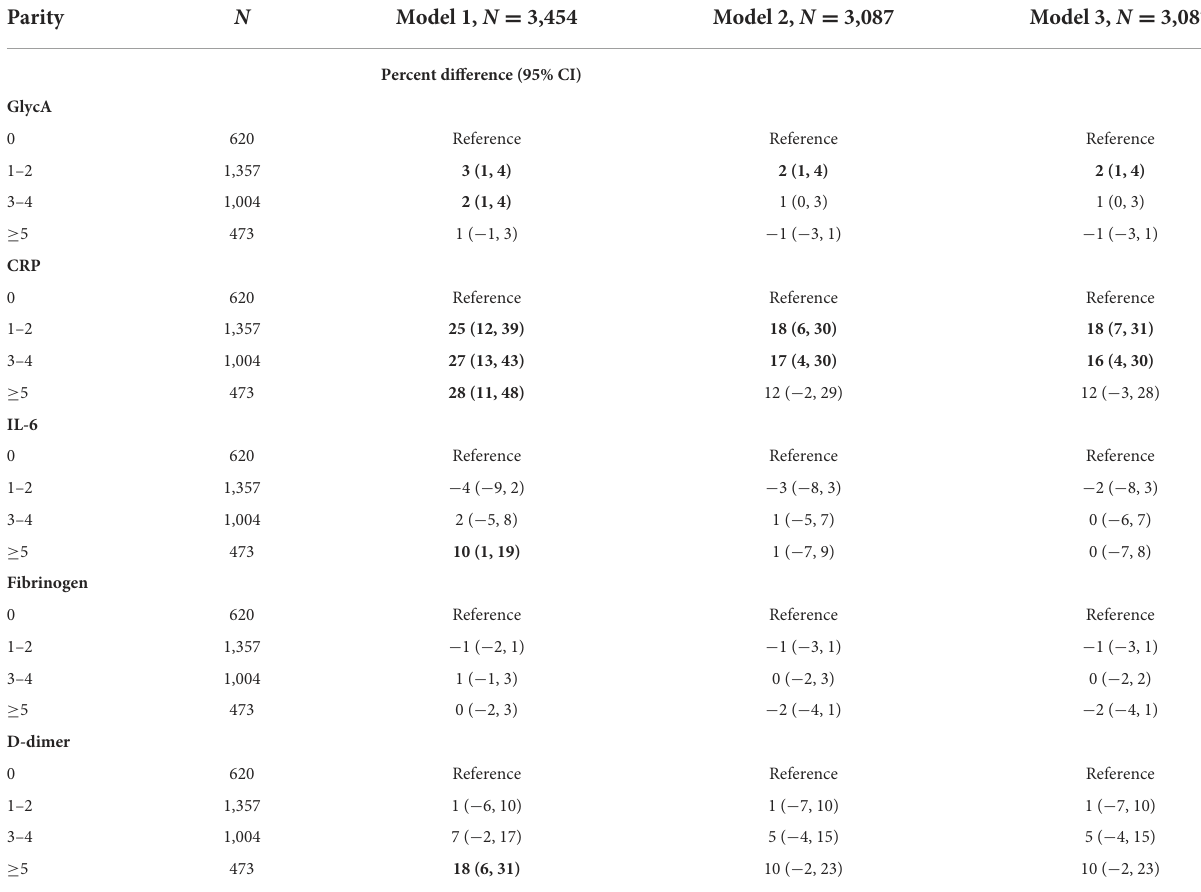
TABLE 2 Association between parity and inflammatory markers in MESA. Parity